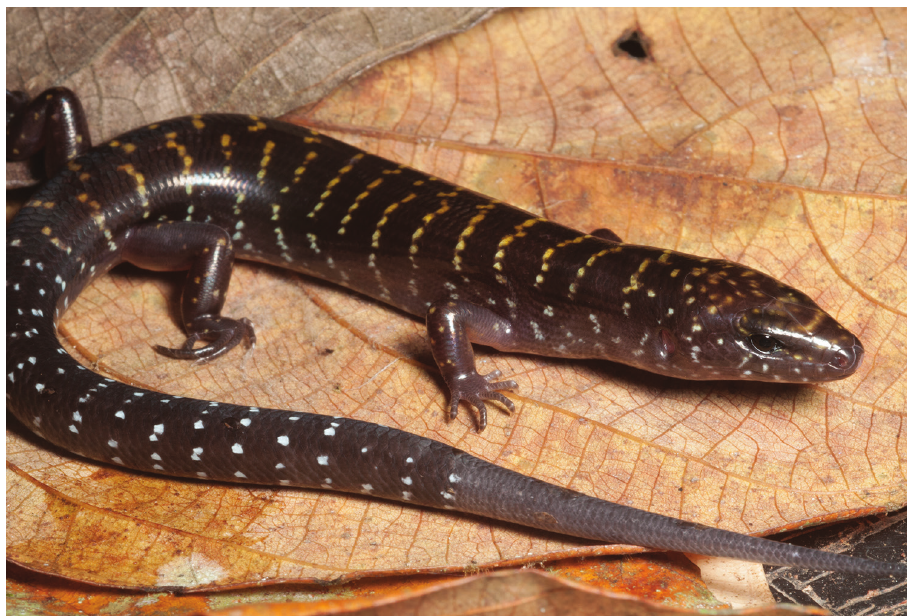
Figure 60. Sphenomorphus fasciatus (KU 334087) from Mt. Hilong-hilong, Municipality of Remedios T. Romualdez, Agusan del Norte Province. Photo: